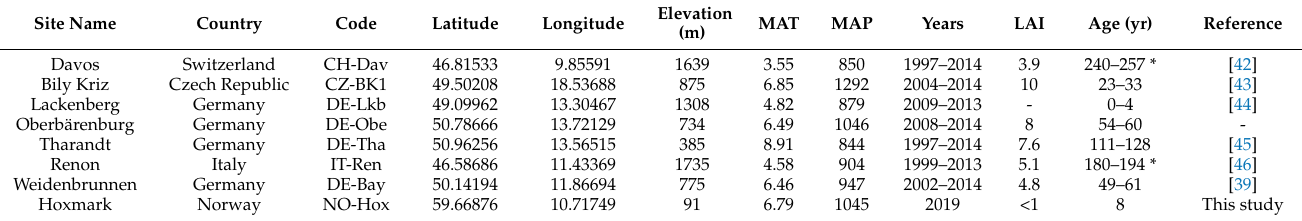
Table 1. Summary of the study